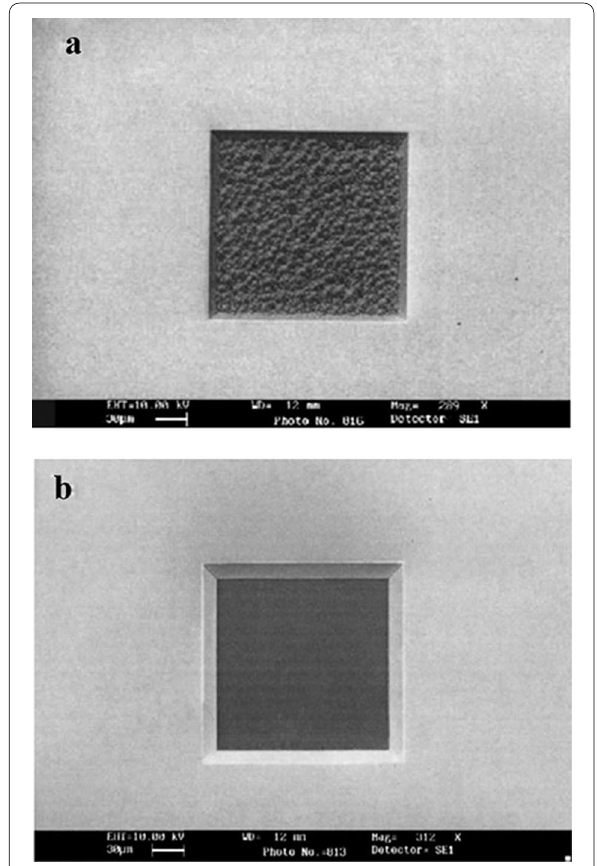
Fig. 36 SEM micrographs of etched silicon surfaces with dissolved 1.6 wt% silicon a without and b with 0.5 wt% (NH 4 ) 2 S 2 O 8 in 5